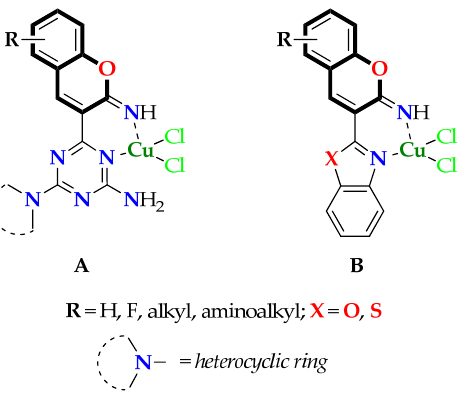
Figure 1. General structure of designed copper(II) complexes of 2-iminocoumarins bearing 1,3,5-triazine ring A and benzoxazole or benzothiazole moiety B .